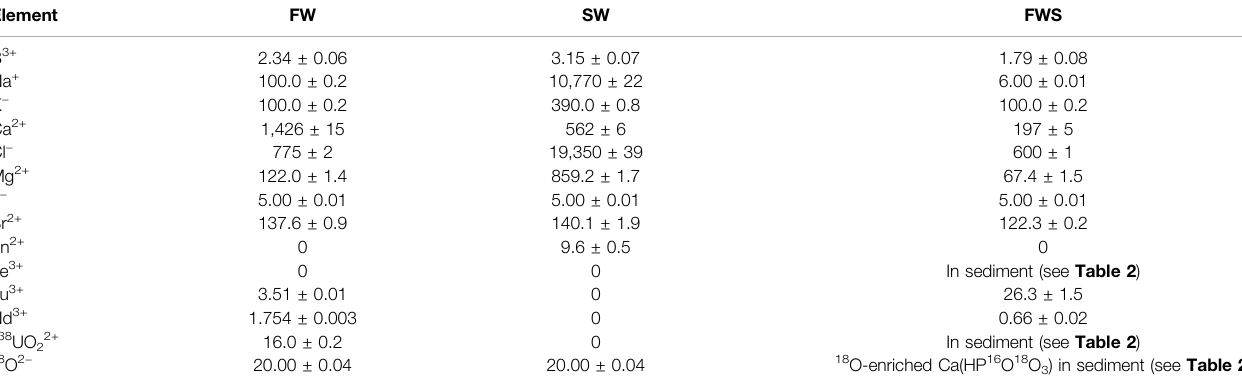
TABLE 1 | Element concentrations of the freshwater (FW), seawater (SW), and the freshwater plus sediment (FWS) stock solutions. Element FW SW FWS B